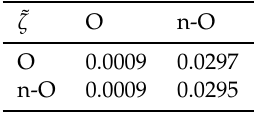
Table 7. Parameter calibration for spillover parameter: ˜ ζ , linearized